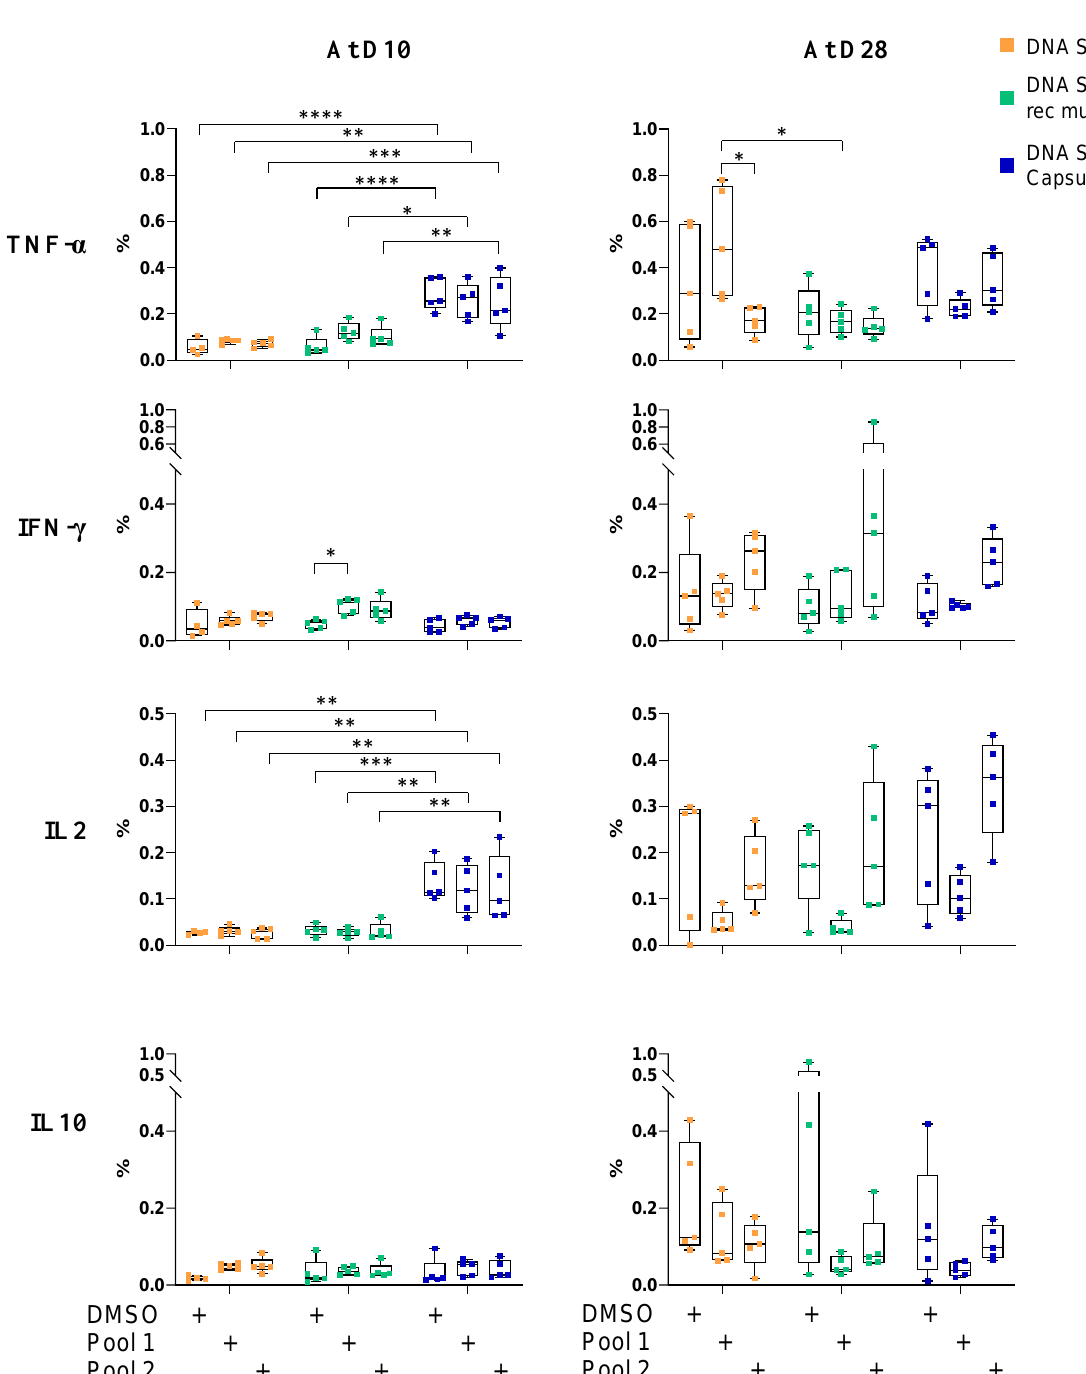
Figure 4. Cytokines profile of spike-specific CD4+ T cells 10 and 28 days after vaccination. Mice were immunized with a single dose of spike DNA plasmid with or without GM-CSF (recombinant or secreted by encapsulated cells) as an adjuvant. T cells responses were measured at day 10 and 28 by intracellular cytokines staining (ICS) after stimulation of splenocyte with spike protein peptide pools or DMSO as a negative control. Data show the percentage of cytokines secreting CD4+ T cells after stimulation. Data show the percentage of responding CD4+ T cells after stimulation. Data are represented as min-to-max boxes with individual values. * p < 0.05, ** p < 0.01, *** p < 0.001, and **** p <